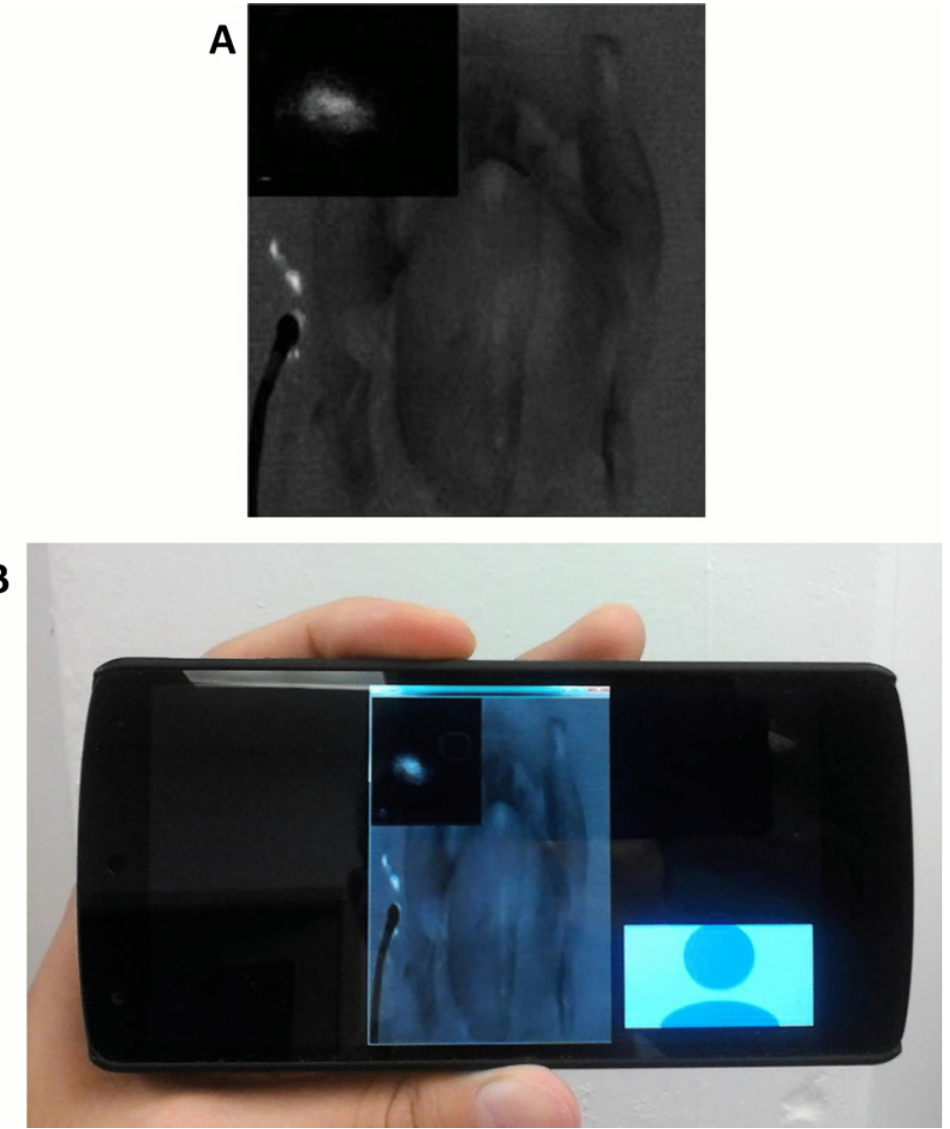
Fig 6. Telemedicine enabled by the Integrated Imaging Goggle. (A) The fluorescence video stream as seen through the remote goggle, transmitted via 4G LTE network. Orange arrows indicate simulated cancerous lesions. (B) The received fluorescence video frame displayed on the remote viewer ’ s smartphone on the go. Red arrows indicate simulated cancerous